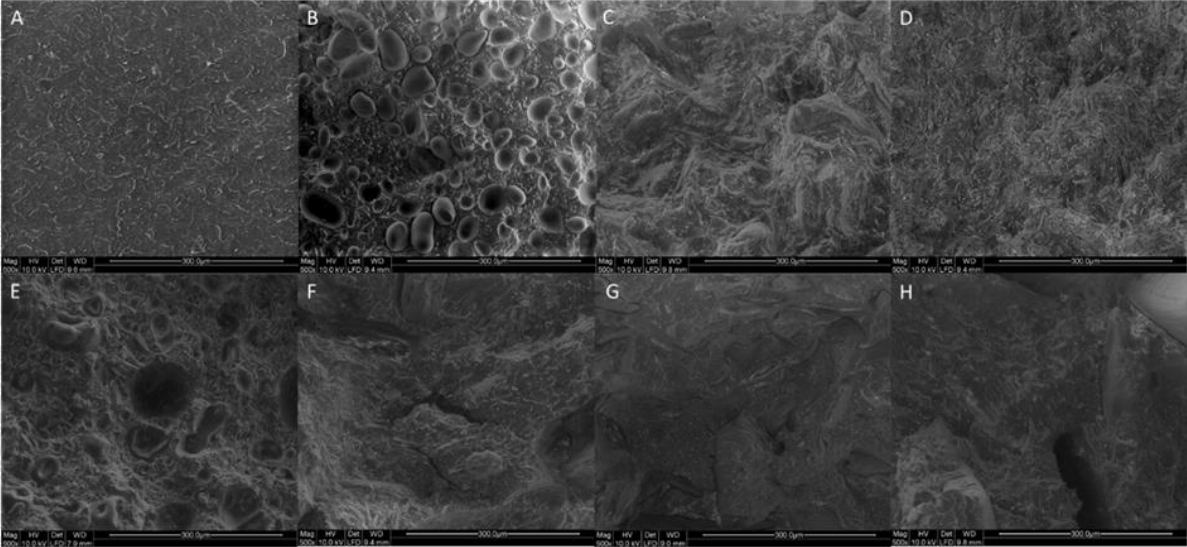
Figure 1. SEM micrographs of the fractured surfaces of neat PHB ( A ) and PHB composites reinforced with starch ( B ), chitin ( C ), cellulose ( D ), soy protein ( E ), orange waste ( F ), chitosan ( G ), and sawdust ( H ). All micrographs have the same magnification of 500x.